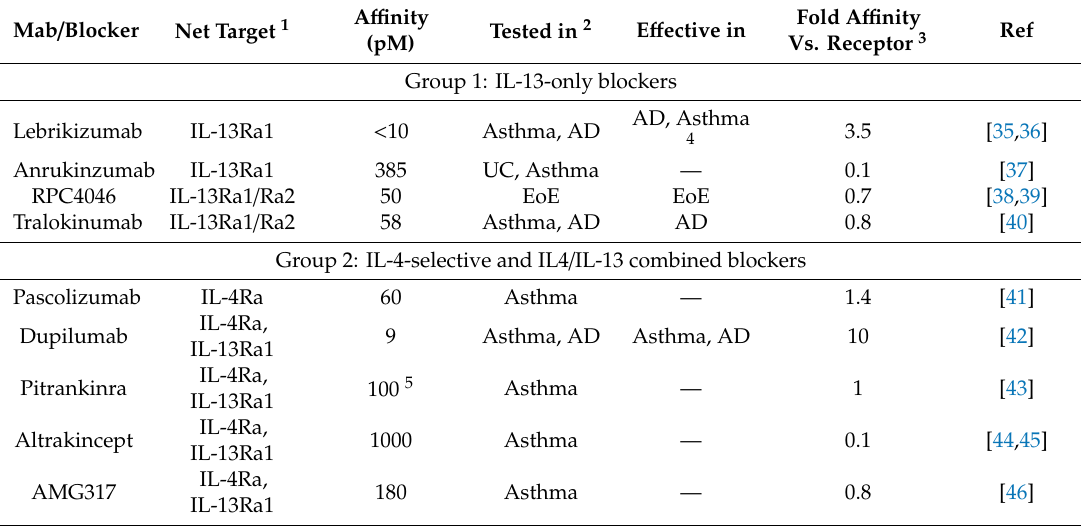
Table 2. Ligand a ffi nities and a ffi nities relative to ligand–receptor binding of various cytokine-binding clinically used